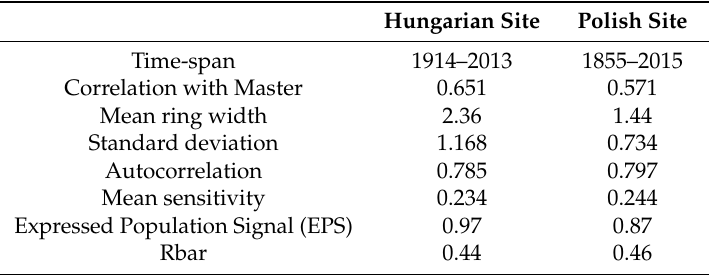
Figure 2. Tree-ring widths (TRW) of Scots pine from Hungary (solid line) and Poland (dashed line). The biggest difference between the two chronologies was the mean ring width. Tree-rings at the Hungarian site were almost one millimeter wider on average than at the Polish site. The standard deviation was also higher at the Hungarian site but autocorrelation and mean sensitivity were similar (Table 2). Table 2. Comparison of descriptive statistics for both raw data chronologies. Correlation with Master: the average correlation of each series with a master chronology derived from all other series; Standard deviation: Year-to-year differences in tree-ring measurement; Autocorrelation: a measure of the previous year ′ s influence on current year ′ s growth; Mean sensitivity: the relative change in ring-width from one year to the next; Expressed Population Signal (EPS): climate-related signal preserved in the index series, Rbar: mean inter-series correlation.